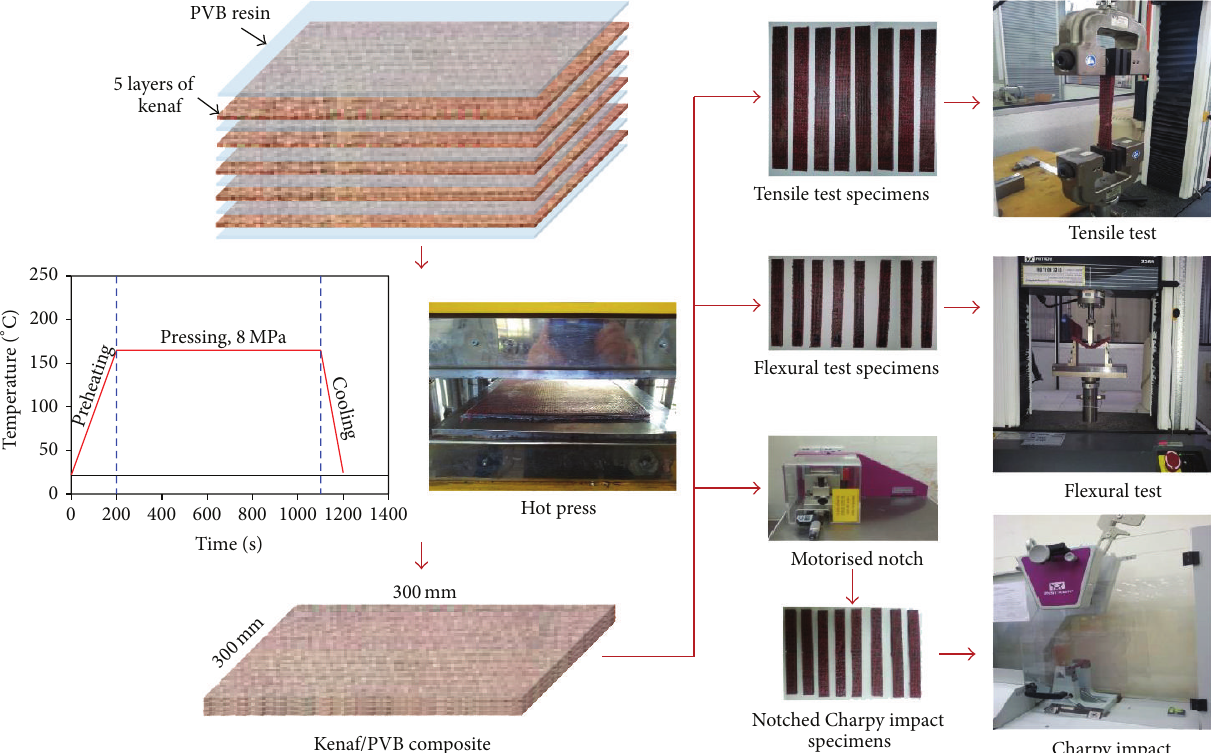
Figure 2: Drawing of the plain woven kenaf/PVB composite laminates by using the hot press technique and the temperature profile.